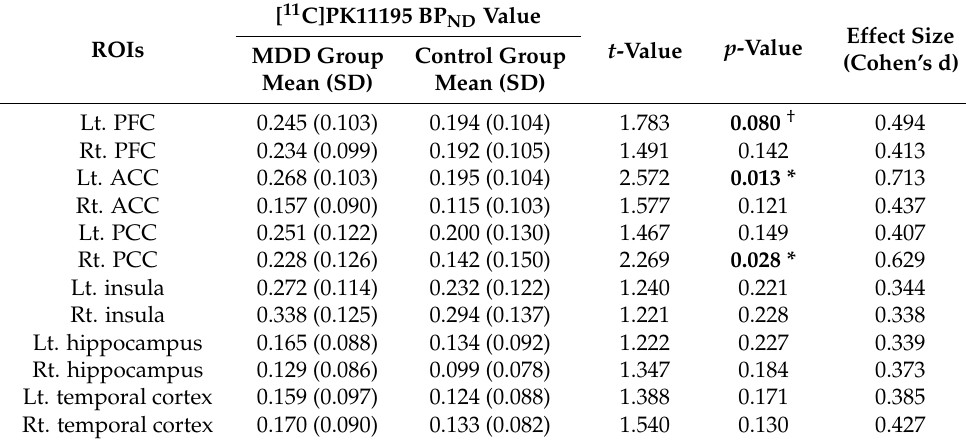
Table 2. ROI-based between-group comparisons of regional [ 11 C]PK11195 BP ND values.